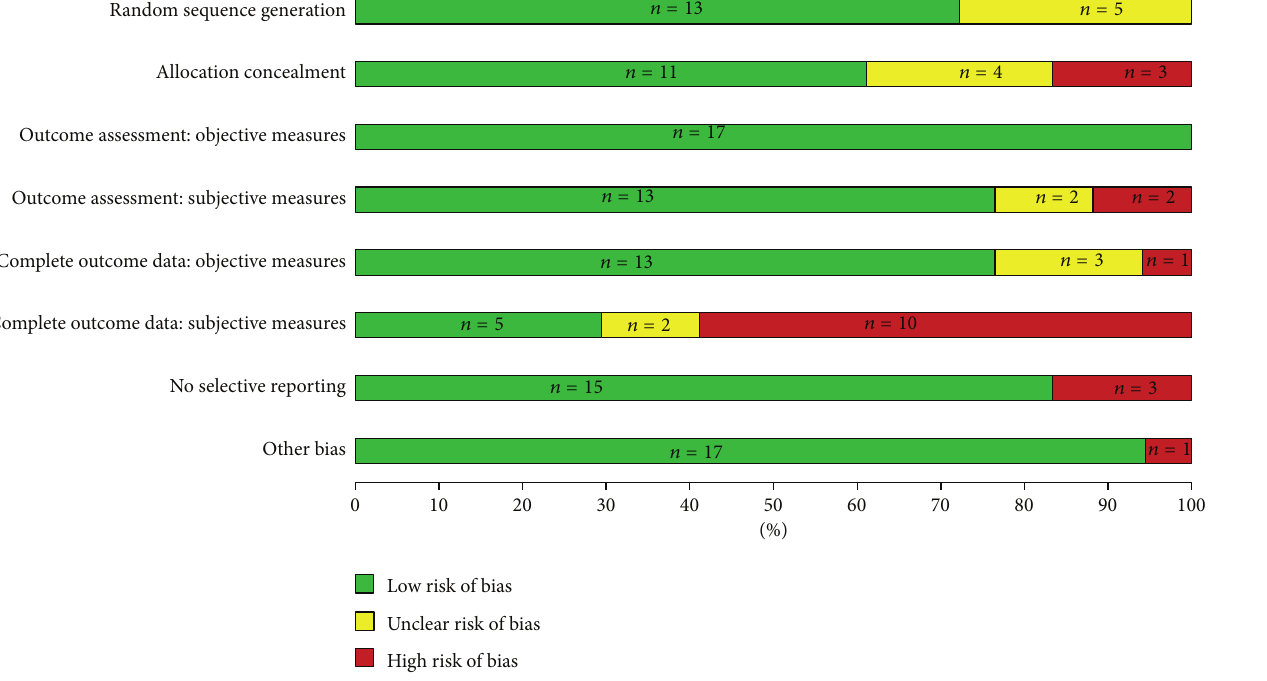
Figure 4: Risk of bias horizontal graph of NP studies ( 𝑛 = 18